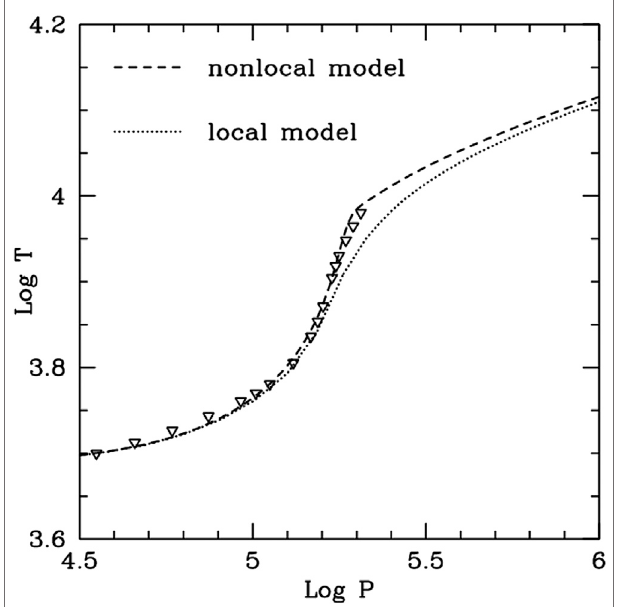
FIGURE 4 | Relative difference in the squared sound speed δ C 2 / C 2 (solid-line) and density δρ / ρ (dotted-line) between the non-local and local convection models of the Sun versus fractional radius r / R ⊙